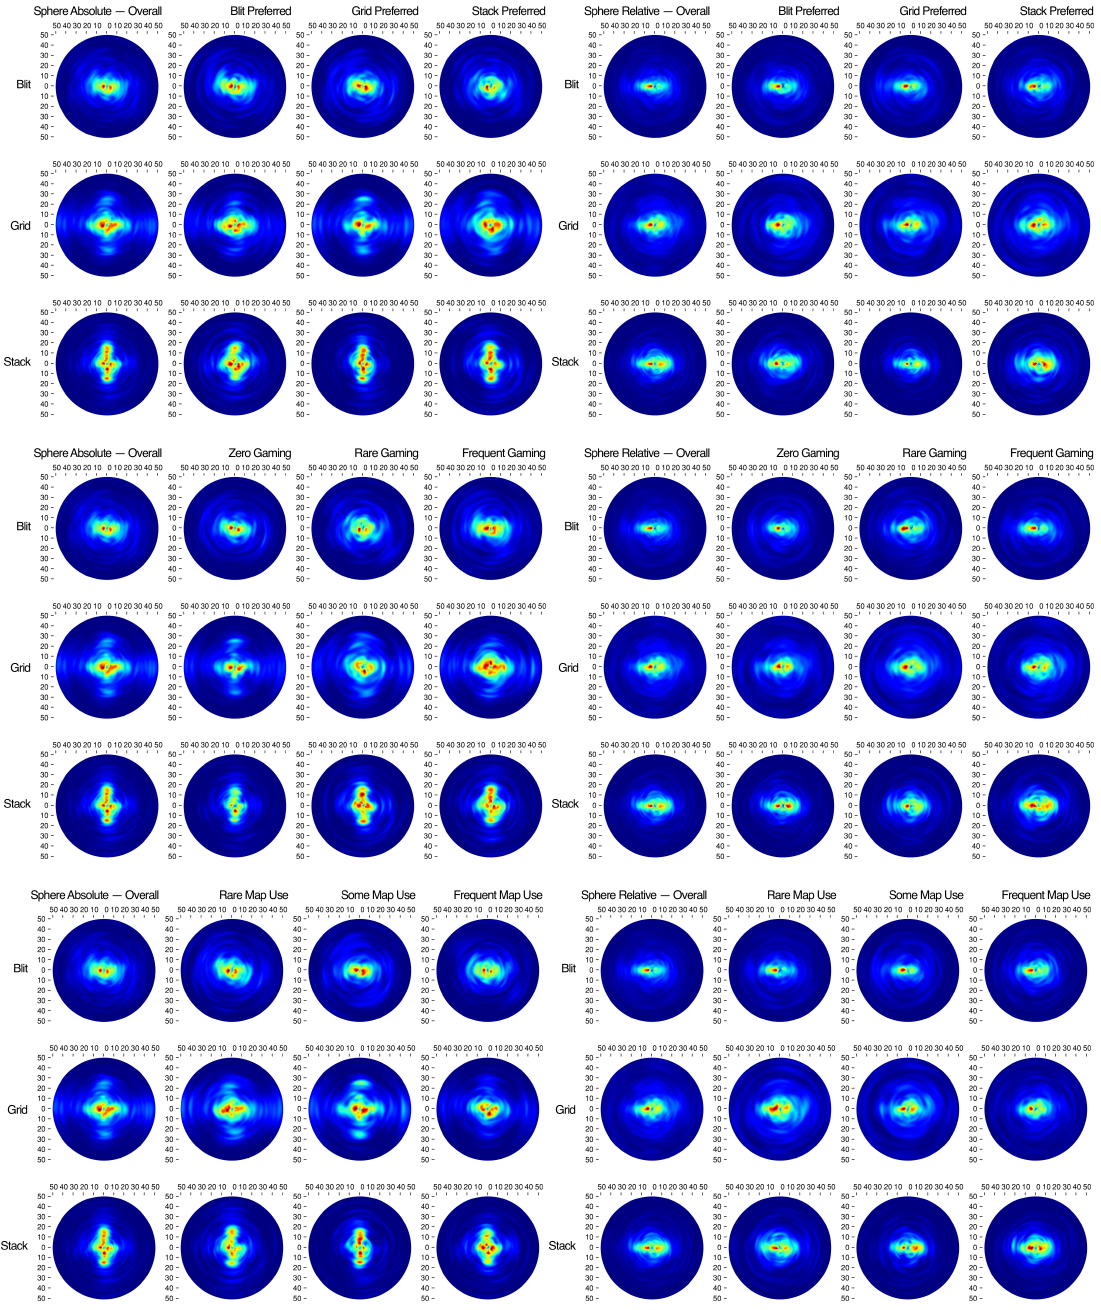
Figure A5. Polar plots showing the density probability distributions of absolute and relative total saccades—the gaze, as projected on a sphere—in degrees, represented as polar plots, for each MCV system (blit/grid/stack) and subgrouped by the participants’ preference for an MCV system regarding its legibility ( top ), the frequency with which they play video games ( middle ), and the frequency with which they consult city maps ( bottom